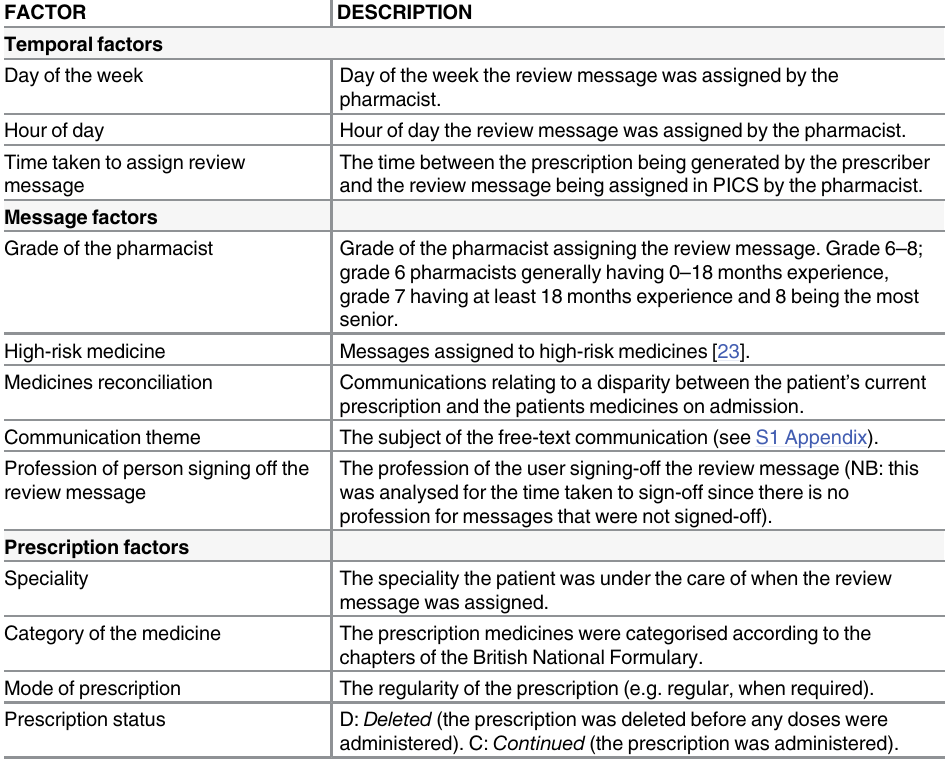
Table 1. Factors included in the generalised estimating equations